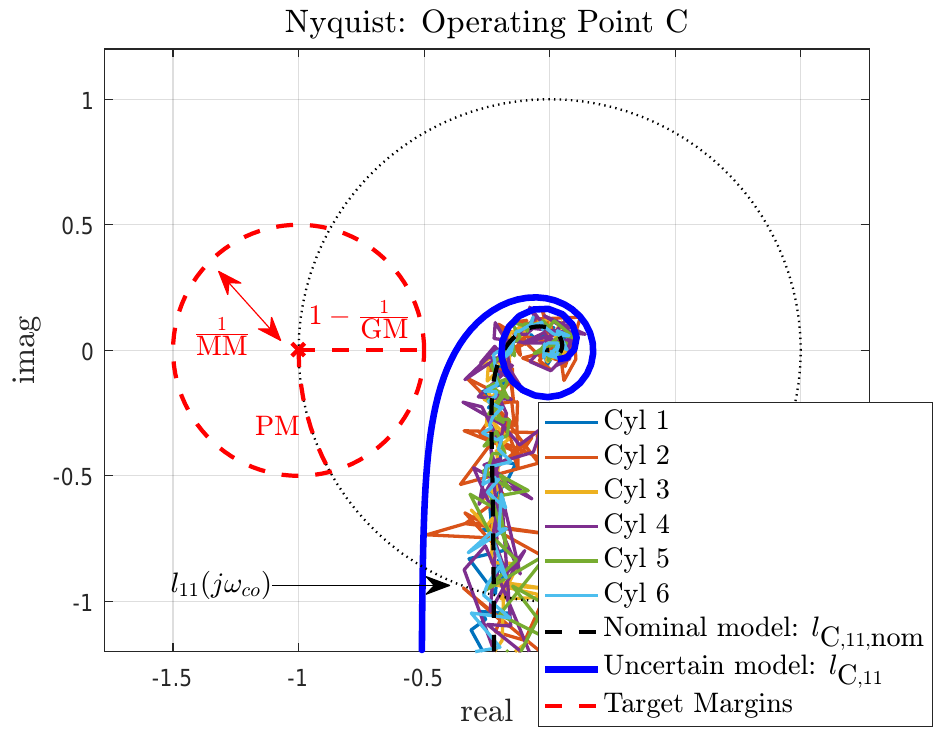
Figure A2. Nyquist plot of l C,11 for six individual cylinders (operating point